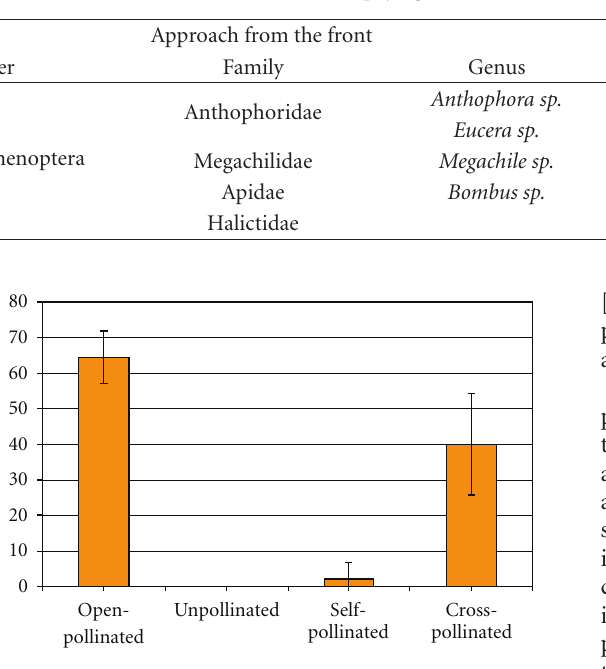
Figure 7: Hand pollination experiment in C. emerus . Reproductive success is expressed as percent of flowers which developed pods with seeds. Bars indicate confidence intervals ( P < 0 .